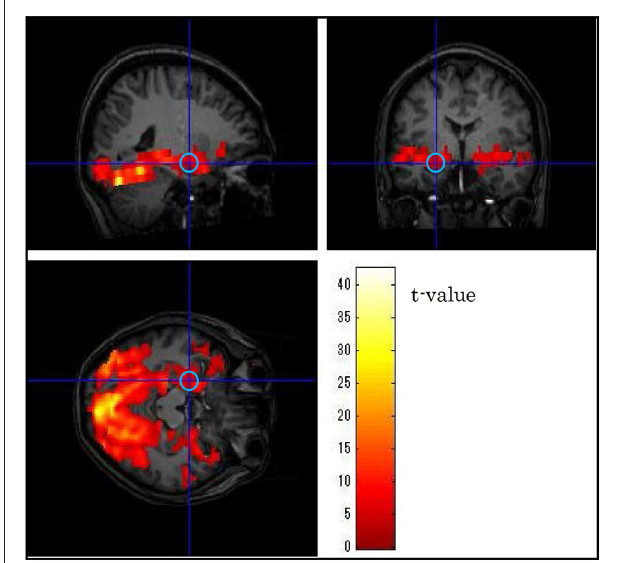
FIGURE 3 | Example of the position of a volume of interest (left amygdala) in one subject . The central position was determined using as guides neuroanatomical atlases and three-dimensional activation